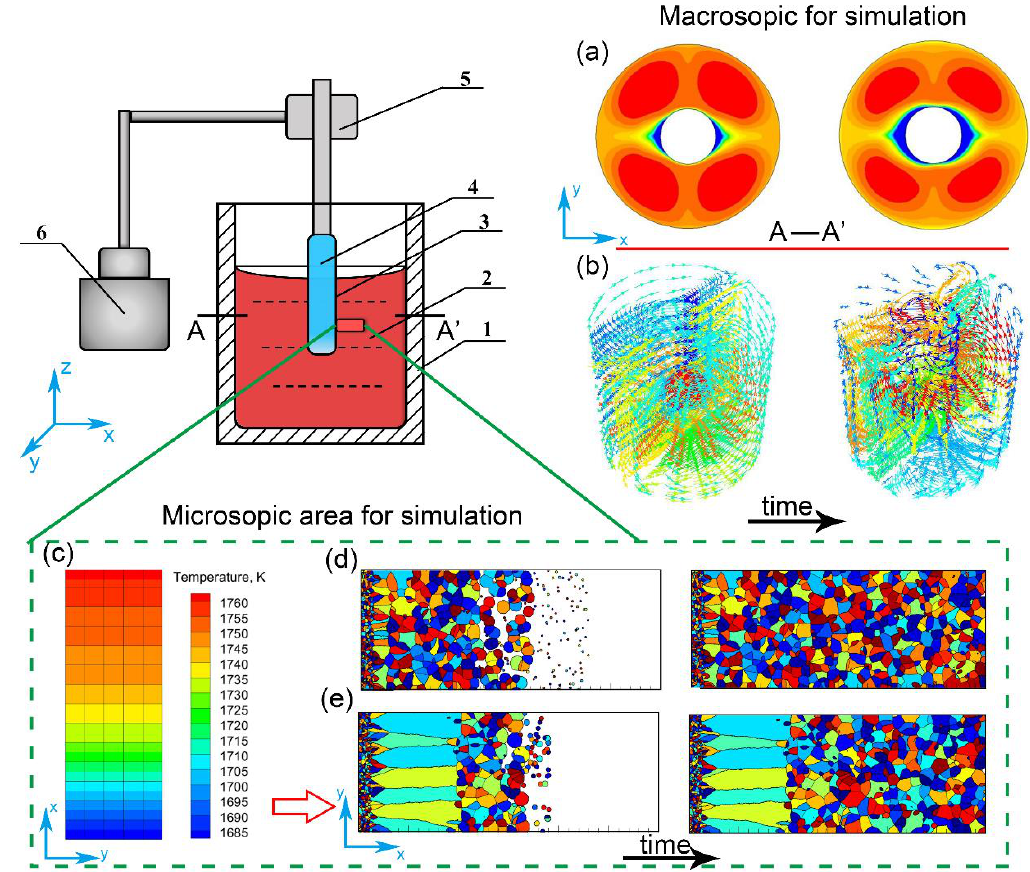
Figure 1. The schematic diagram of the vibration-excited liquid metal nucleation experimental apparatus and the simulation principle: 1-cylindrical mold, 2-melt, 3-crystal nucleus generator, 4-water circulation cooling structure, 5-vibration instrument, and 6-power source and transmission. ( a ) Two-dimensional temperature field distribution along the A–A’ section at different times. ( b ) Three-dimensional fluid flow trace diagram. ( c ) Modeling domain for microstructure formation. ( d ) The full equiaxed dendrites formed at different stages. ( e ) The process of columnar dendrites and equiaxed dendrites competitive